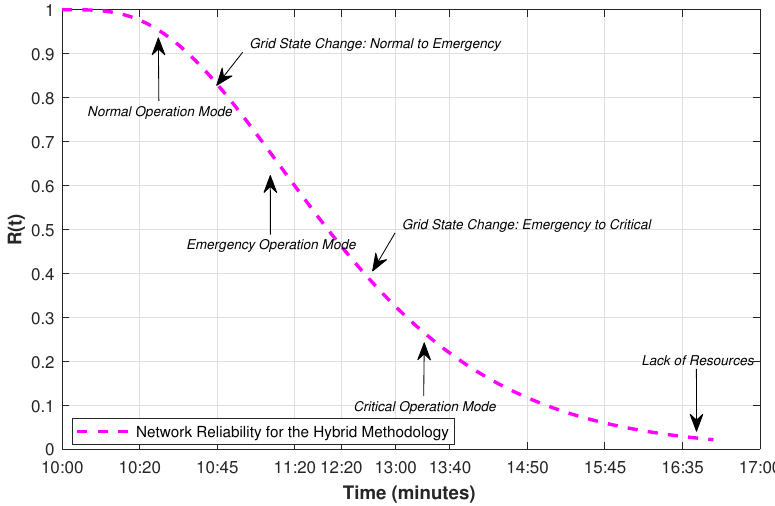
Figure 5. Microgrid communication system reliability for the hybrid